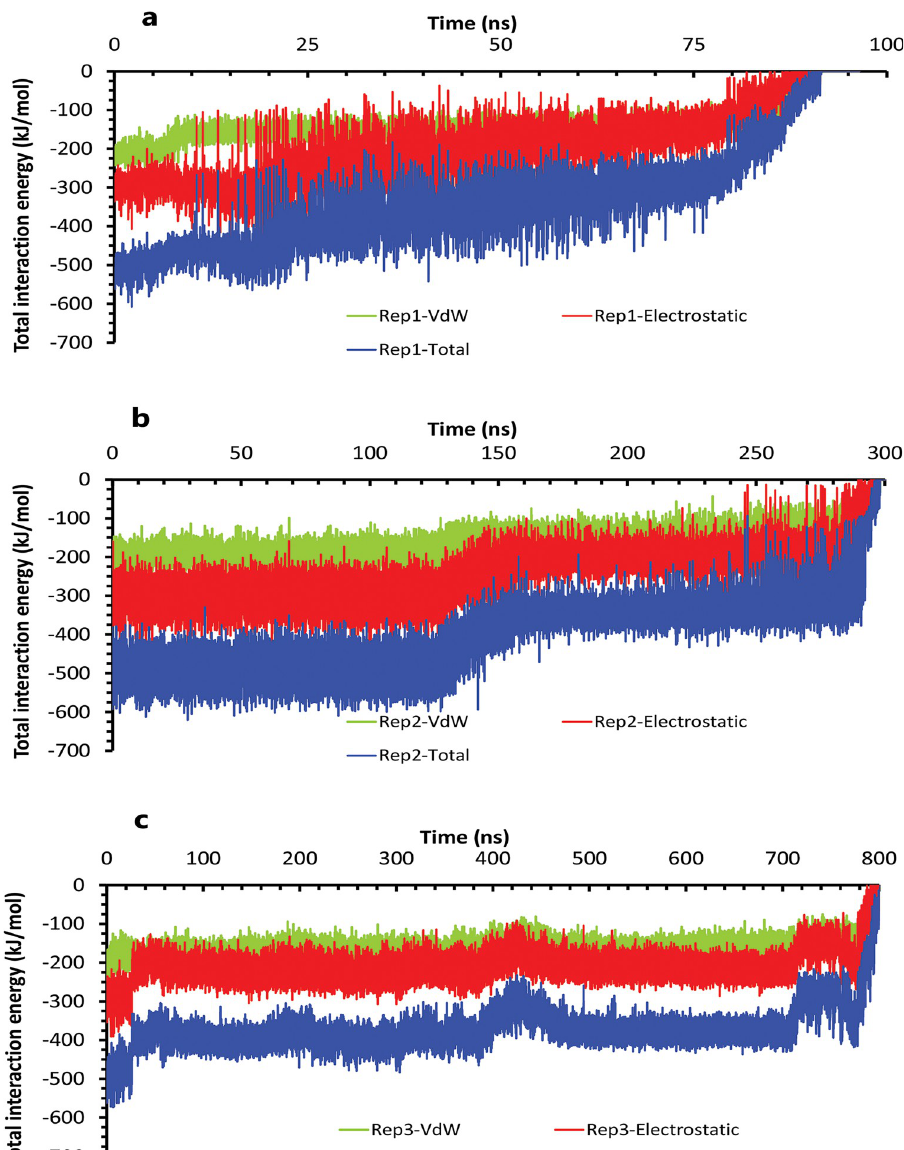
Fig 9. The interaction energies plots of compound 10 in complex with HTLV-1 protease when Asp32 of chain B was protonated in three replicas. A , B , and C , The total VdW and electrostatic interactions energies of protein- inhibitor complexes in rep1, 2, and